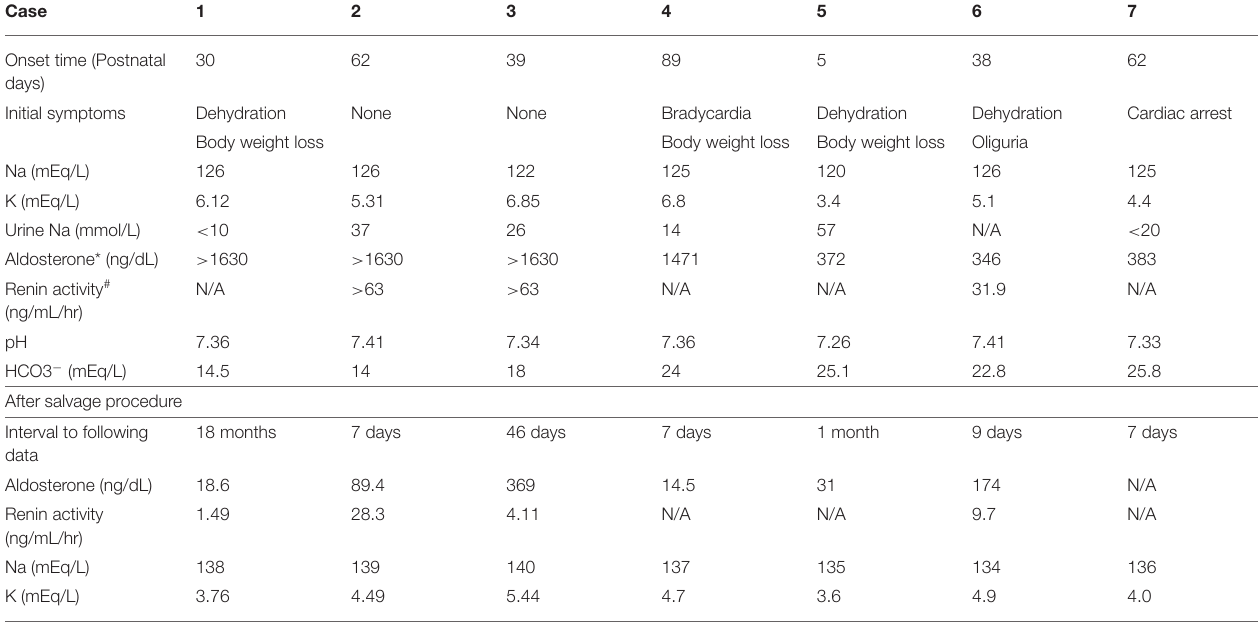
TABLE 2 | Biochemical and hormonal profile of the patients.